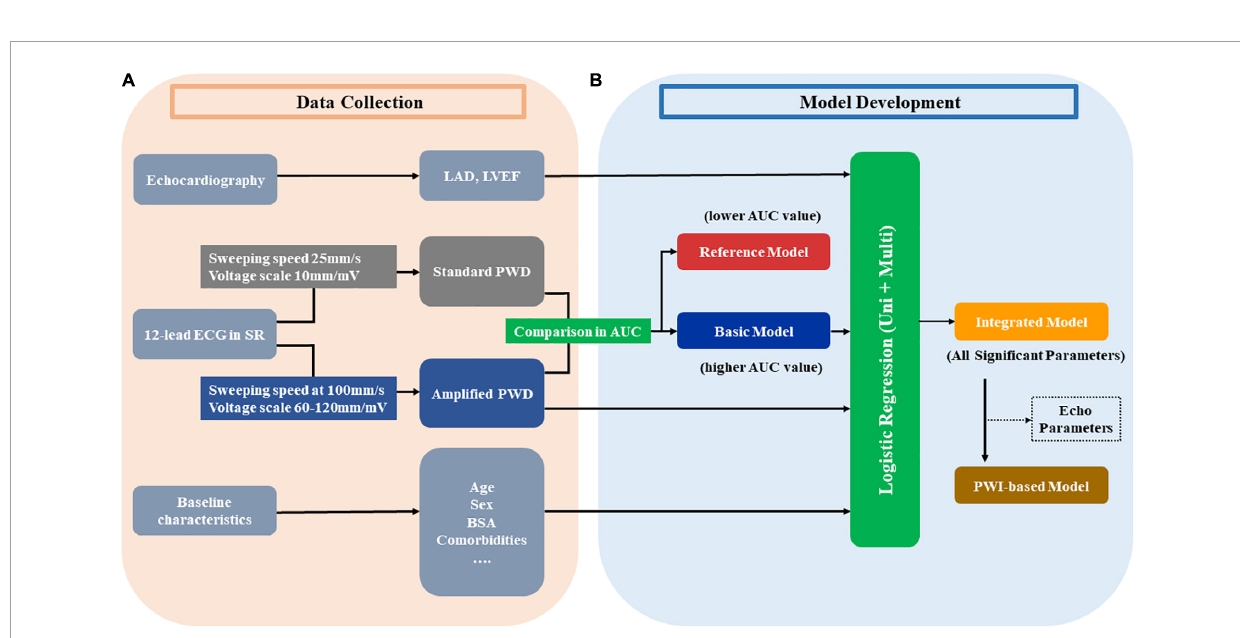
FIGURE3 Development of diagnostic models from the training set. Panel (A) illustrates the data collection in the training set in the current study, different parameters from echocardiography, 12-lead ECG and other baseline characteristics are collected. Every ECG was measured at both standard setting (25 mm/s, 10 mm/mV) and amplified setting (100 mm/s, 60–120 mm/mV) to acquire the standard PWD and amplified PWD, respectively. Panel (B) depicts the steps in developing models. Amplified PWD and standard PWD were compared regarding their AUC in discriminative power to identify patients with AF. The one with higher AUC value is used as the basic model and proceed to further steps whereas the one with lower AUC value is used as the reference model. Basic model, along with other echo and baseline parameters are selected by univariate and subsequent multivariate parameters. The integrated model consists of all the significant parameters from the logistic analysis. Additionally, in order to create an alternative model with less variables and more oriented at ECG parameters, a PWI-based model is developed by excluding echo parameters (if any) from the integrated model. AUC, area under the curve; BSA, body surface area; ECG, electrocardiography; Echo, echocardiography; LAD, left atrial diameter; LVEF, left ventricular ejection fraction; PWD, p-wave duration; PWI, p-wave index; Uni, univariate; Multi,